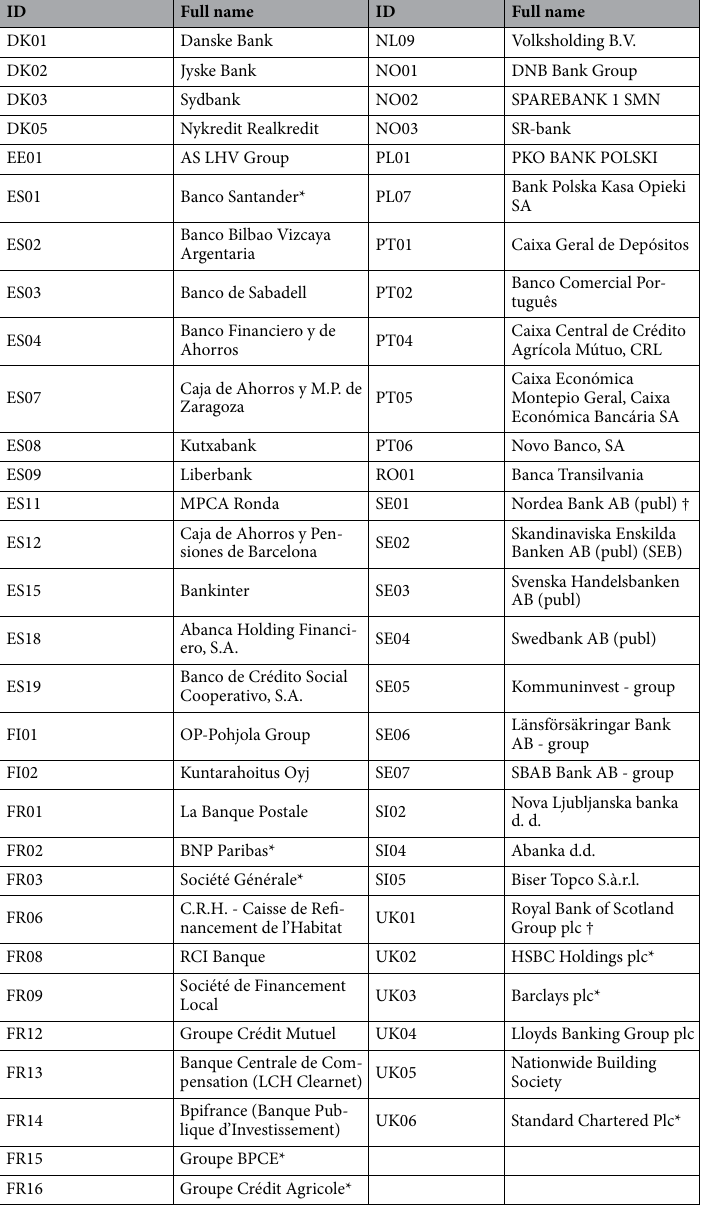
Table 1. IDs and full names of banks in the 2018 EBA Network. Banks marked by asterisk (*) were G-SIBs in all years (2014, 2016, 2018); banks marked by dagger ( † ) were G-SIBs in 2014 and 2016, but not in